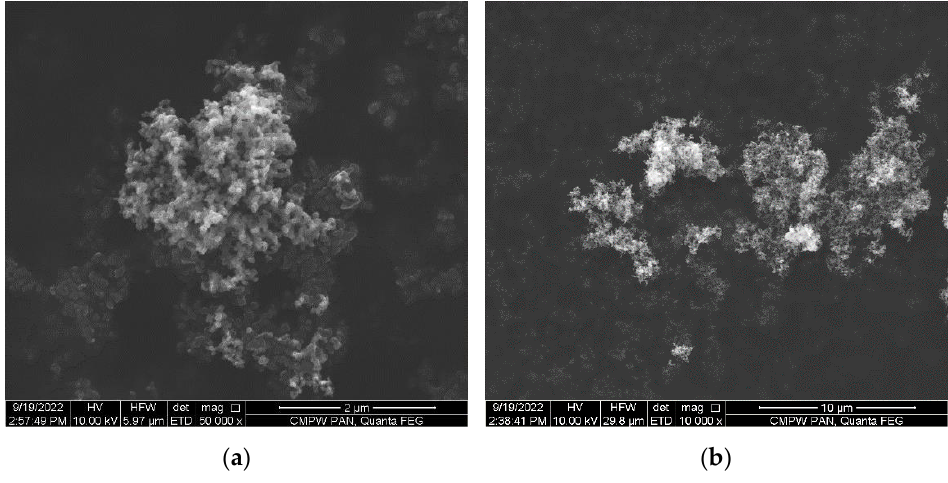
Figure 1. SEM images of the carbon black (CB) ENSACO 250G ( a , b ).